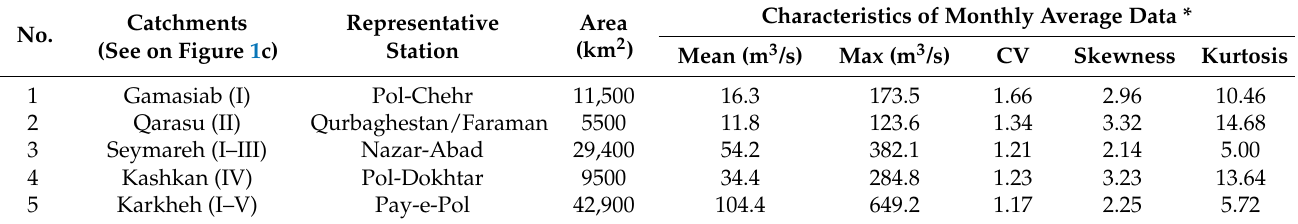
Table 1. The drainage basin area and overview of monthly average runoff data in the different sub-catchments of the KRB for the period between September 1999 and September